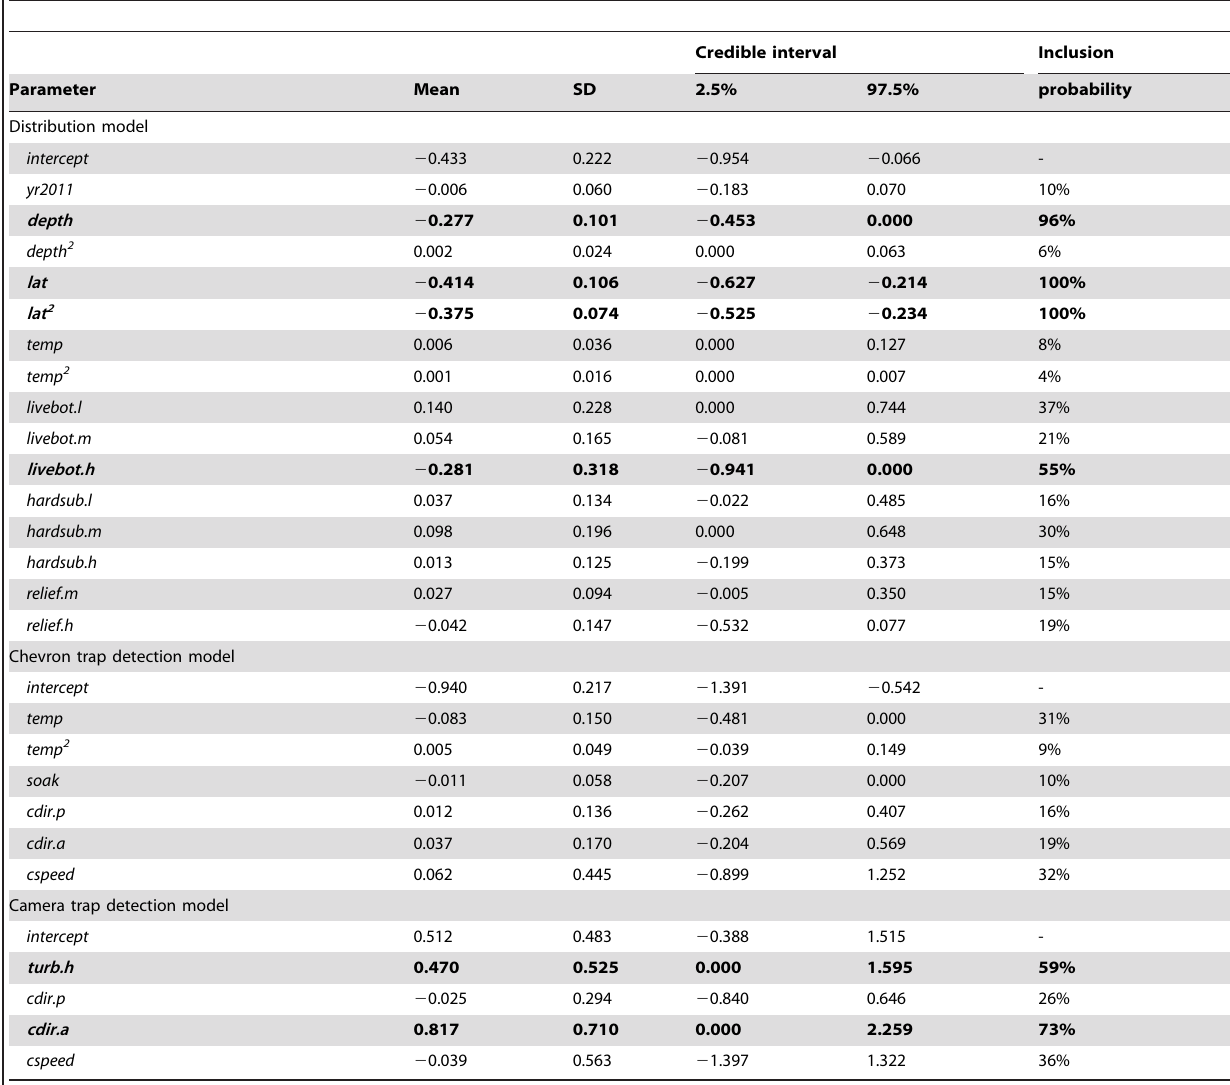
Table 4. Posterior probability summaries of parameters evaluated in the red snapper Lutjanus campechanus Royle-Nichols occupancy model using pooled camera trap data and without a site-specific random effect on abundance (Pois( l ) Bin( p chevron ) Bin( p camera